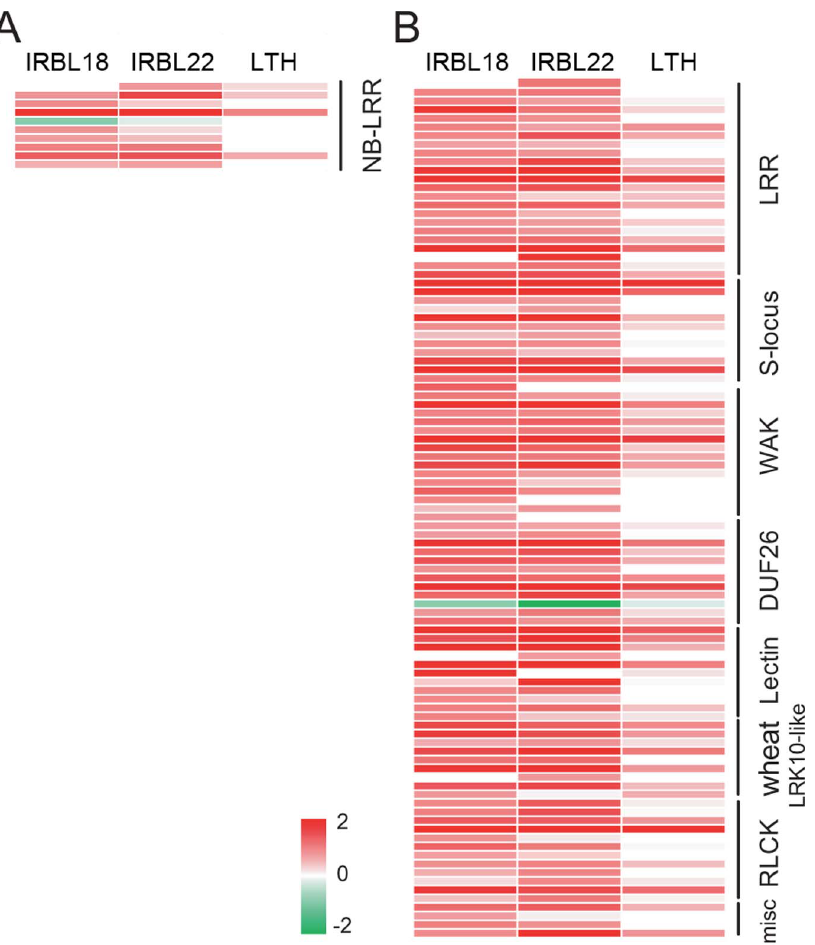
Figure 4. The expression patterns of receptor kinase and nucleotide binding and leucine rich repeat ( NB-LRR ) genes. A: The expression patterns of NB-LRR genes. B: The expression patterns of receptor kinase genes, with the family names shown on the right side. The scale bar displays log2-transformed fold changes.